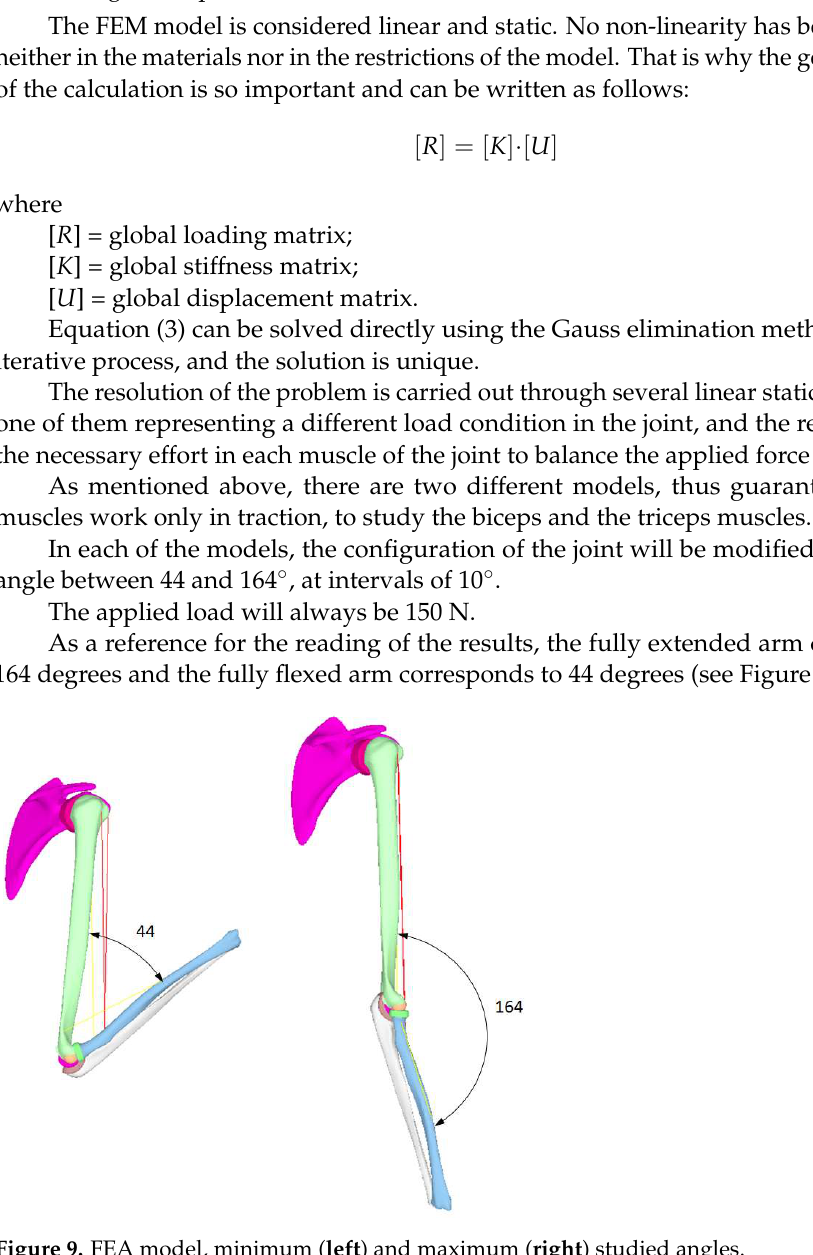
Figure 9. FEA model, minimum ( left ) and maximum ( right ) studied